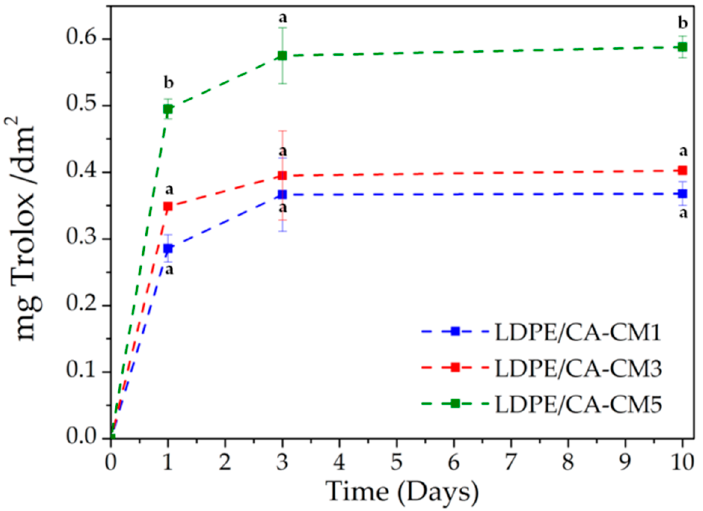
Figure 6. The C. metuliferus fruit extract antioxidant activity measured by ABTS method. a–b Different superscripts within the same day indicate significant differences between formulations ( p < 0.05).